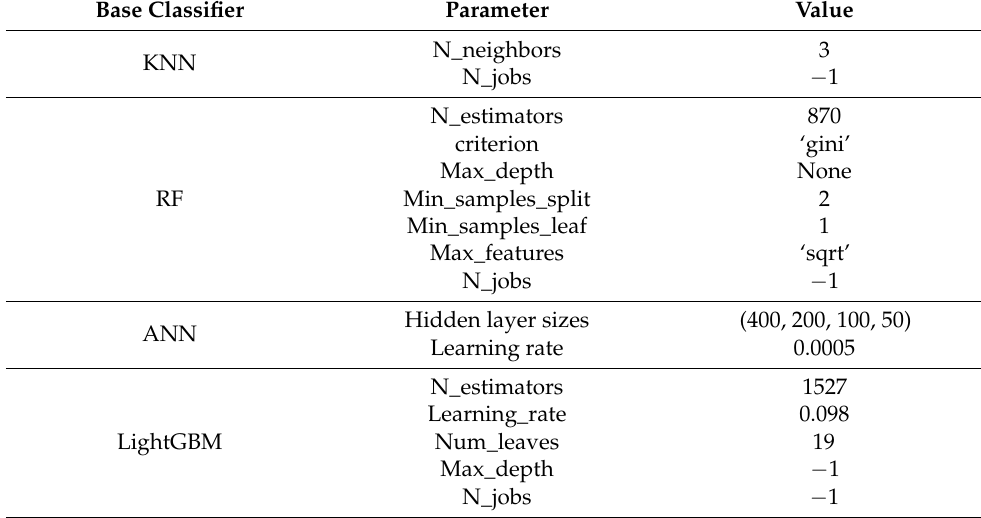
Table 4. Main parameter settings of the base